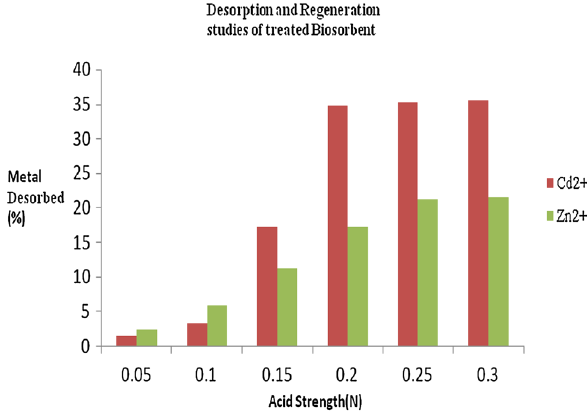
Fig. 13 Desorption and regeneration studies of Cd 2 ? and Zn 2 ? on treated